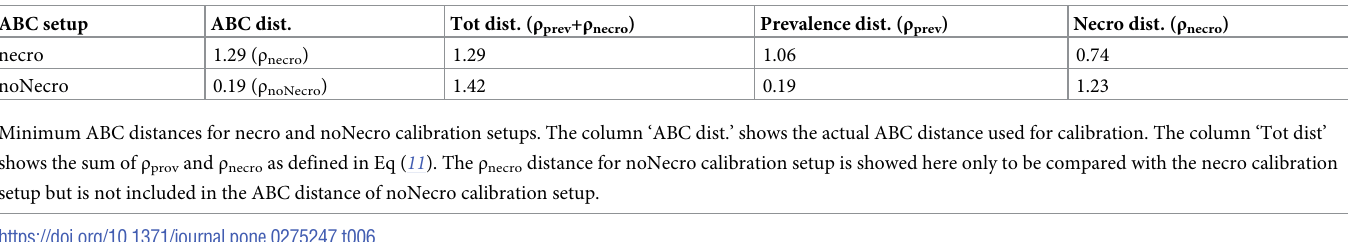
Values of simulated HT and PC prevalence of noNecro ABC setups compared to the observed prevalence. The simulated values are the product of simulation run using the third calibration stage necro, and the fourth stage noNecro setups. The Relative Errors (RE) is defined as: |Prev obs -Prev sim |/Prev obs .